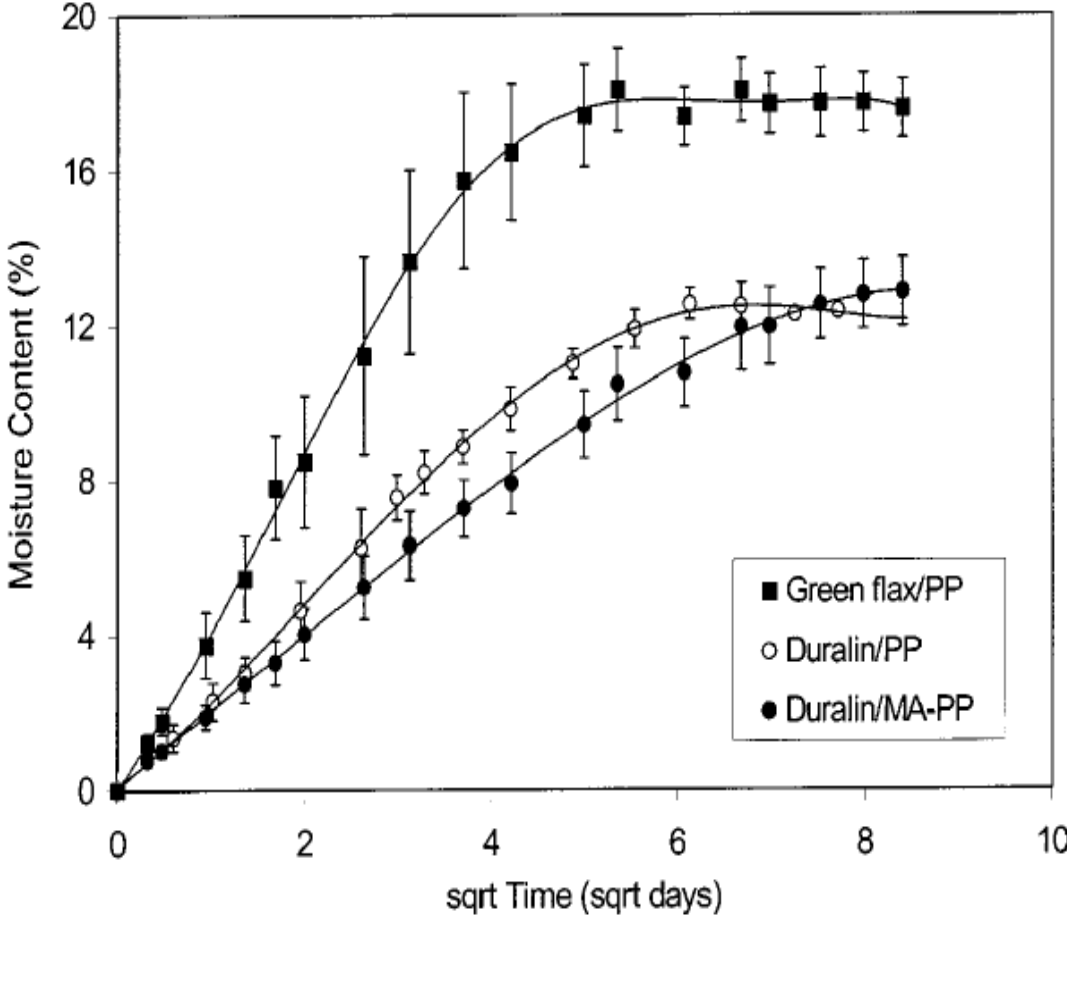
Figure 6. Moisture content of flax/PP composites as a function of time. Adapted with permission from [69]. Copyright 2013 by